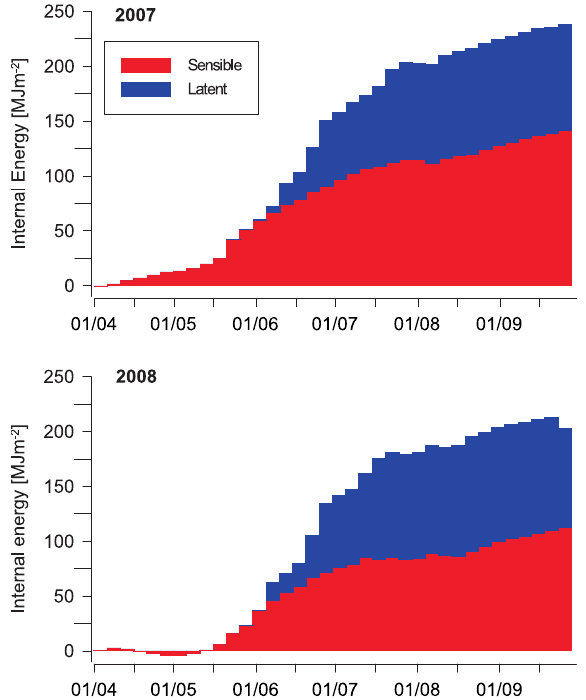
Fig. 5. Internal energy of the soil over the entire observation pe- riod in 2007 and 2008. In both years, 0MJm − 2 is defined as the internal energy of the soil on 1 April. Soil temperatures from 2007 are colder in spring, and the air temperatures are warmer, which explains the increased heat storage at the beginning of the period. Towards the end, soil temperatures are almost